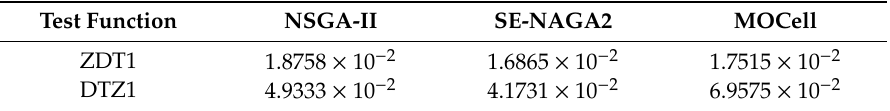
Table 3. Statistical results of the